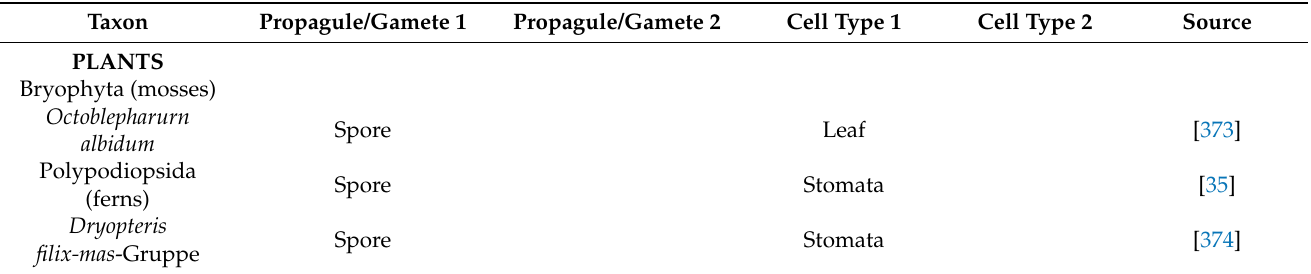
Table A1. Studies showing significant positive associations between sizes of various types of reproductive propagules or gametes and sizes of somatic cells in various taxa of plants and